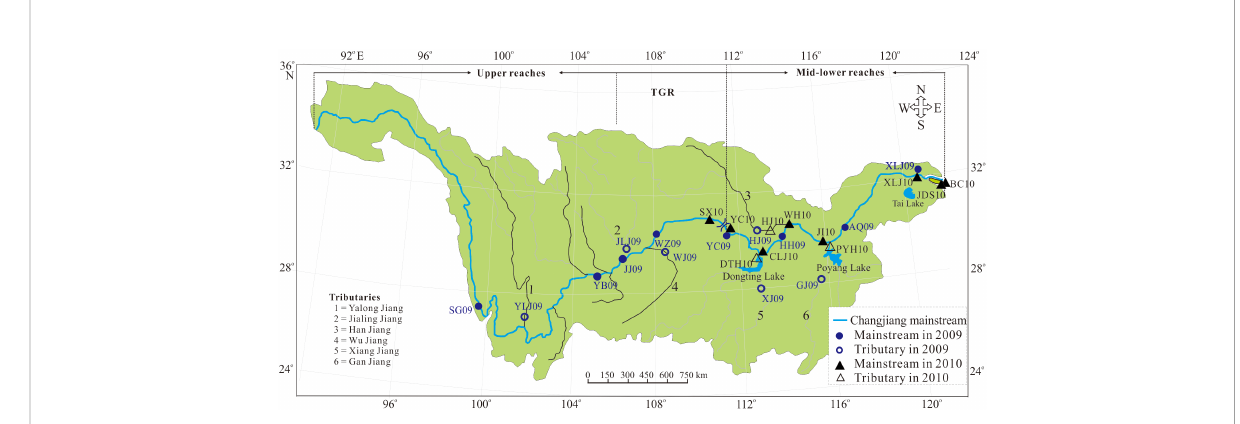
FIGURE 1 The map of sampling sites, blue dots represent the stations collected in 2009; black triangles represent the samples collected in 2010. Different numbers illustrate the tributaries in the watershed. TGR, Three Gorges